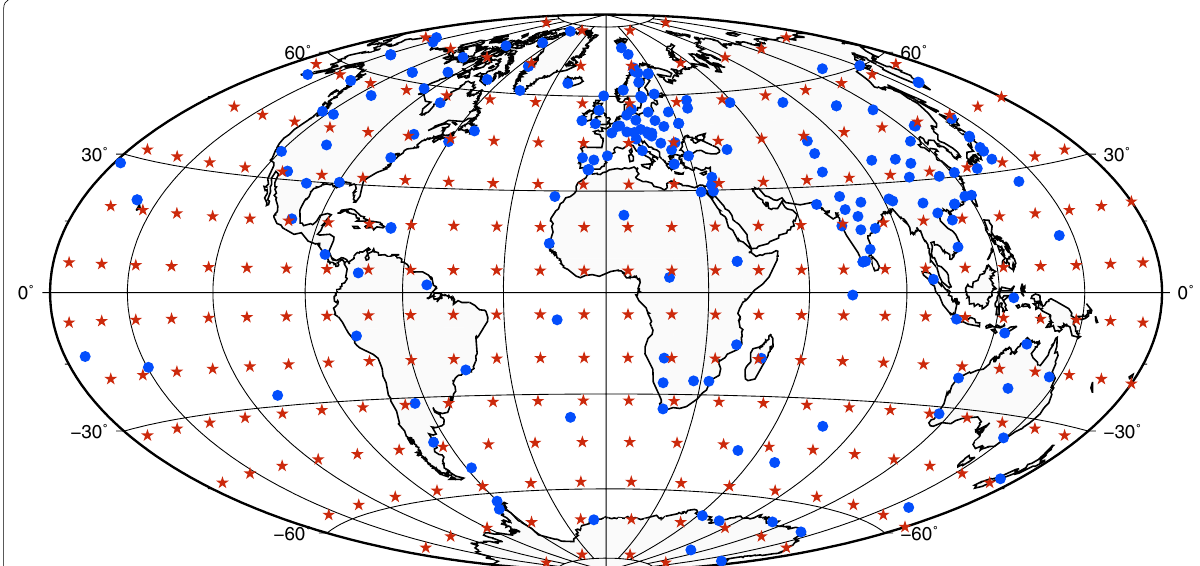
Fig. 1 The distribution of ground-based and satellite virtual geomagnetic observatories. The ground-based observatory data (blue circles) cover the period 1957 to 2018, whereas the VO data (red stars) are derived from Swarm and cover the period 2015 to